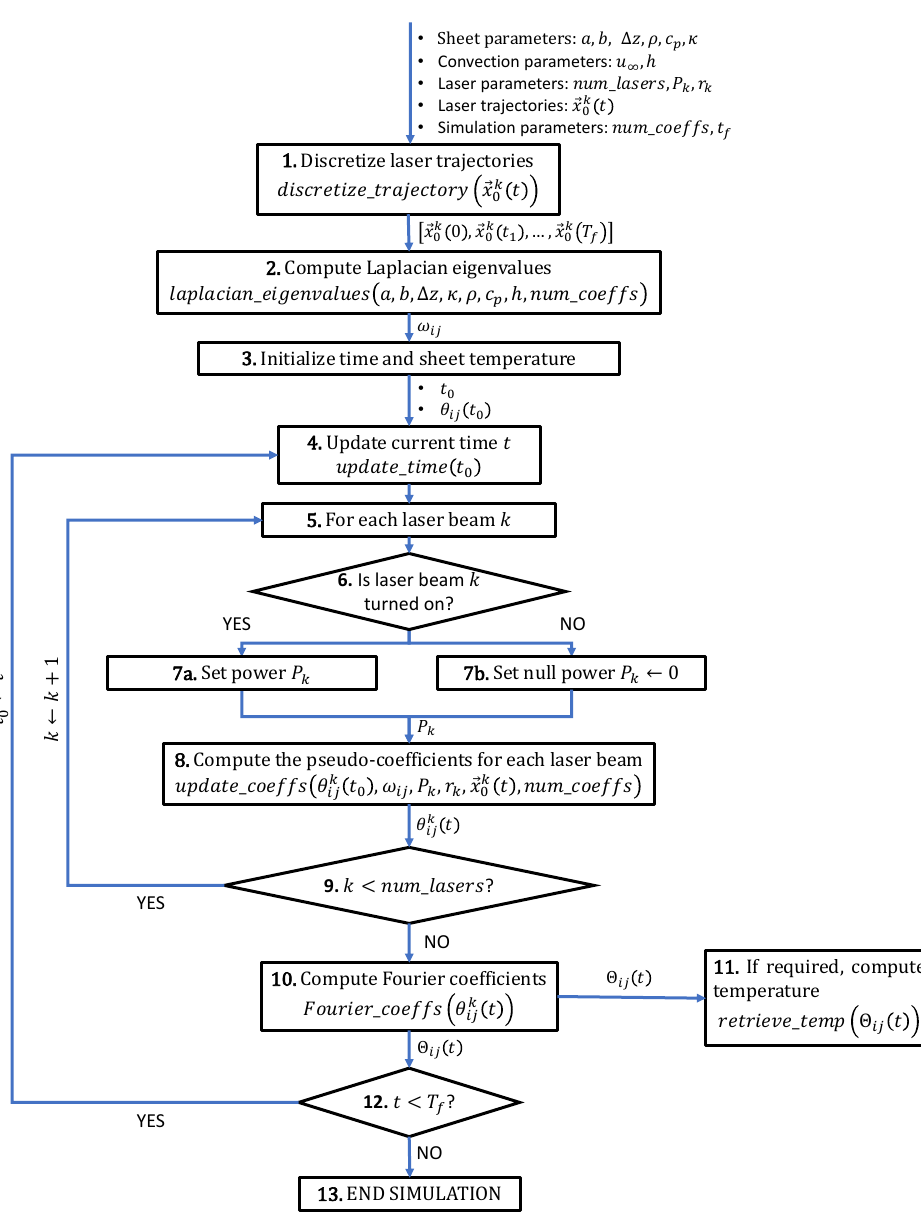
Figure 2. Diagram of the analytic multi-laser simulation